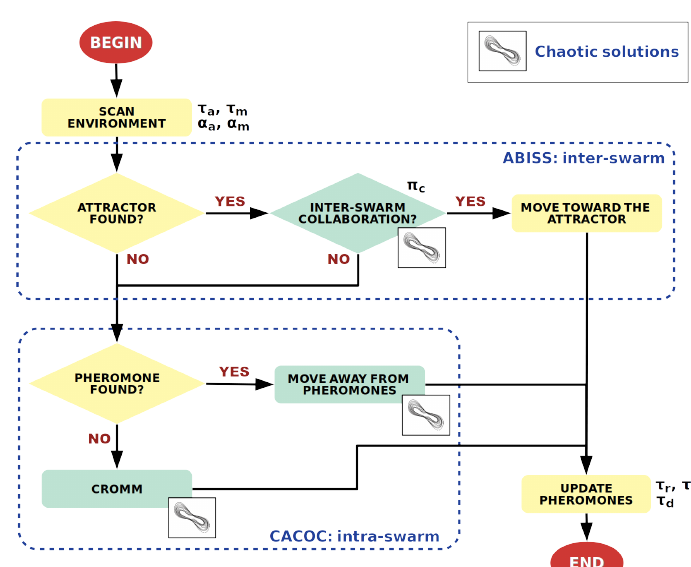
Figure 2. Flow diagram of ABISS using attractors, chaotic solutions and pheromones. The parameters affecting each operation are listed next to them.